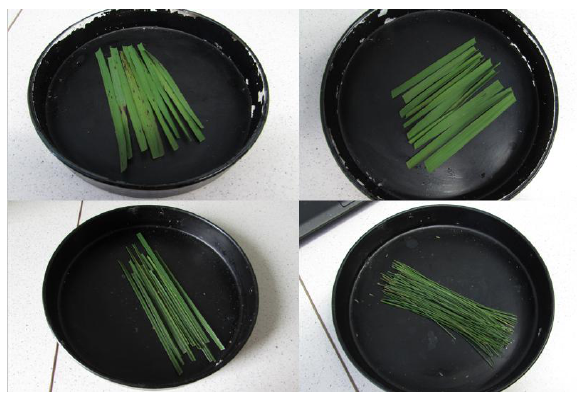
Figure 2. Leaf spectra measurements – the examples of samples of Calamagrostis villosa (upper left), Molinia caerulea (upper right), Deschampsia cespitosa (bottom left) and Nardus stricta (bottom right)